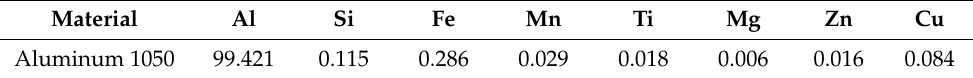
Table 1. Chemical composition (wt.%) of Al1050 used in the current study.